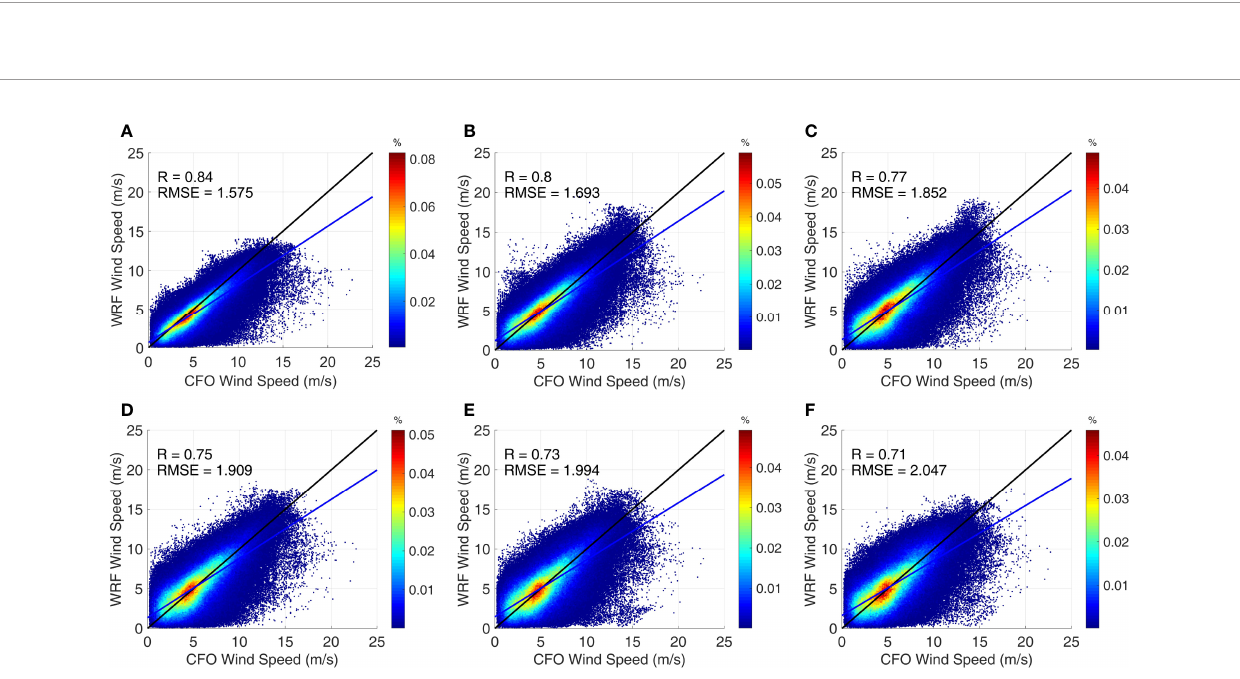
FIGURE 5 | Scatter plot of 10 m wind from observations of CFOSAT (unit: m s -1 ) and (A) reanalysis of ERA5, (B) 0 – 24 h, (C) 25 – 48 h, (D) 49 – 72 h, (E) 73 – 96 h, and (F) 97 – 120 h forecasts of WRF-D01 in the EIO (see Figure 1A ). R is the correlation coef fi cient, and RMSE is the root mean square